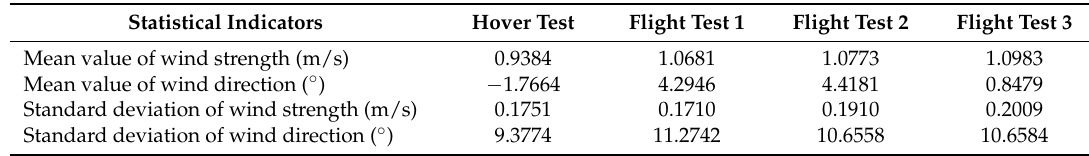
Table 5. Estimation results of the